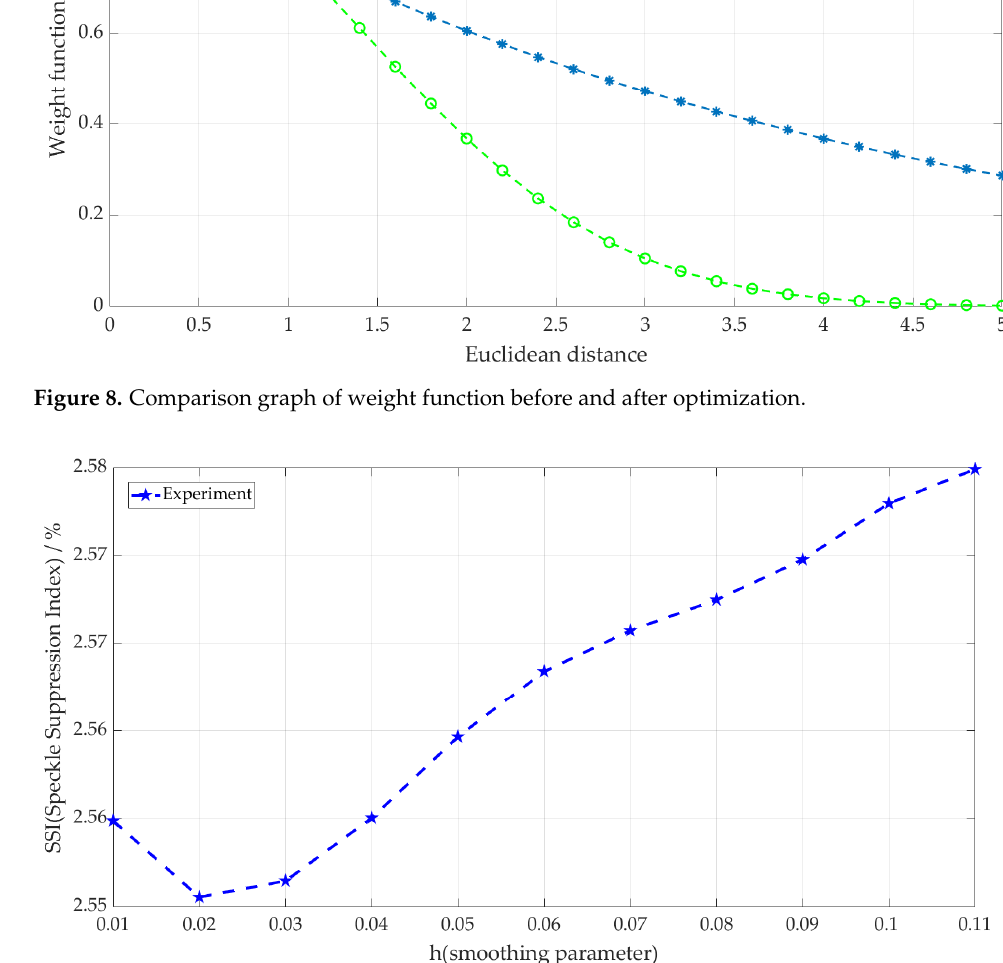
Figure 9. Optimal h value of optimized weight function IW-NLM using adaptive h-solving method.